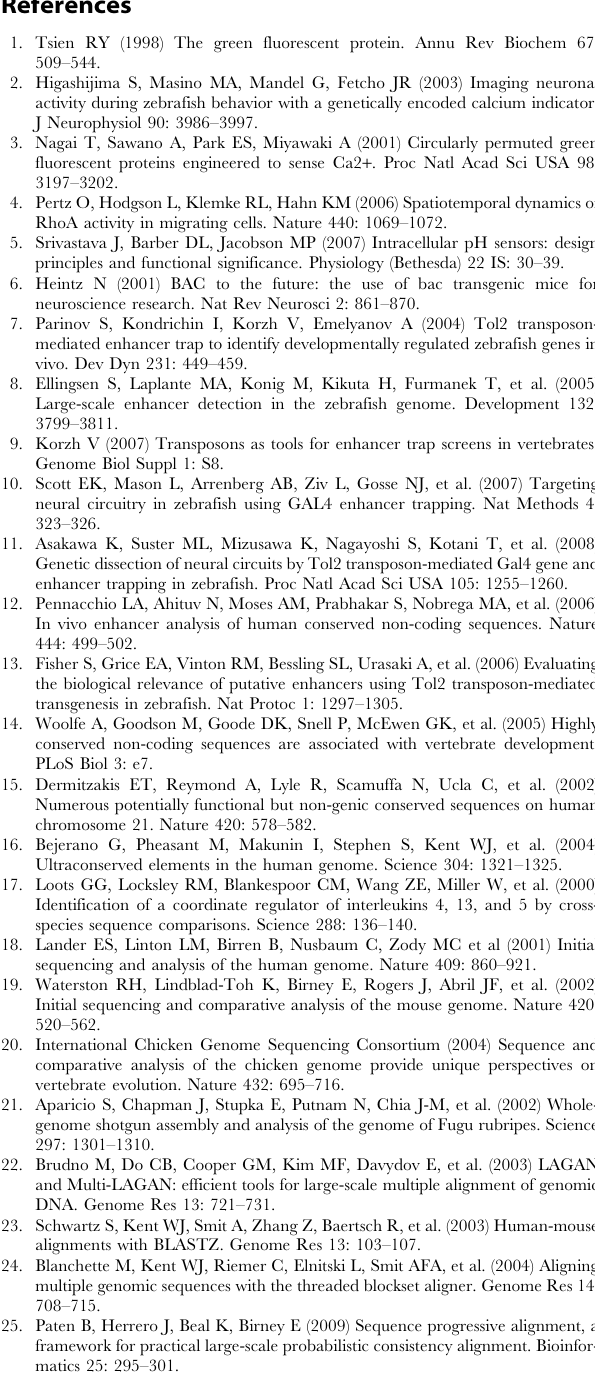
Table S7 Candidates transcription factor predicted to bind CRMs. MEDMOD062537, MEDMOD045693 and MED- MOD086628. For each transcription factor, the name of the factor (from transfac or Jaspar), the name of the zebrafish homolog, the PWM and the partial expression pattern (from ZFIN) is recorded. Table S8 Primer list. Description of all the primers used in this study (candidate CRMs cloning, in-situ probe